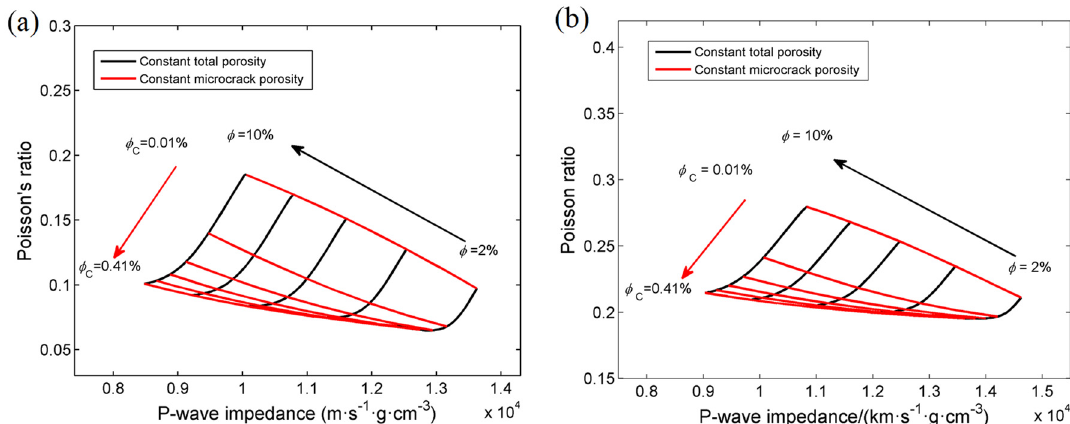
Figure 12. RPTs at ultrasonic ( a ) and sonic ( b ) frequencies.